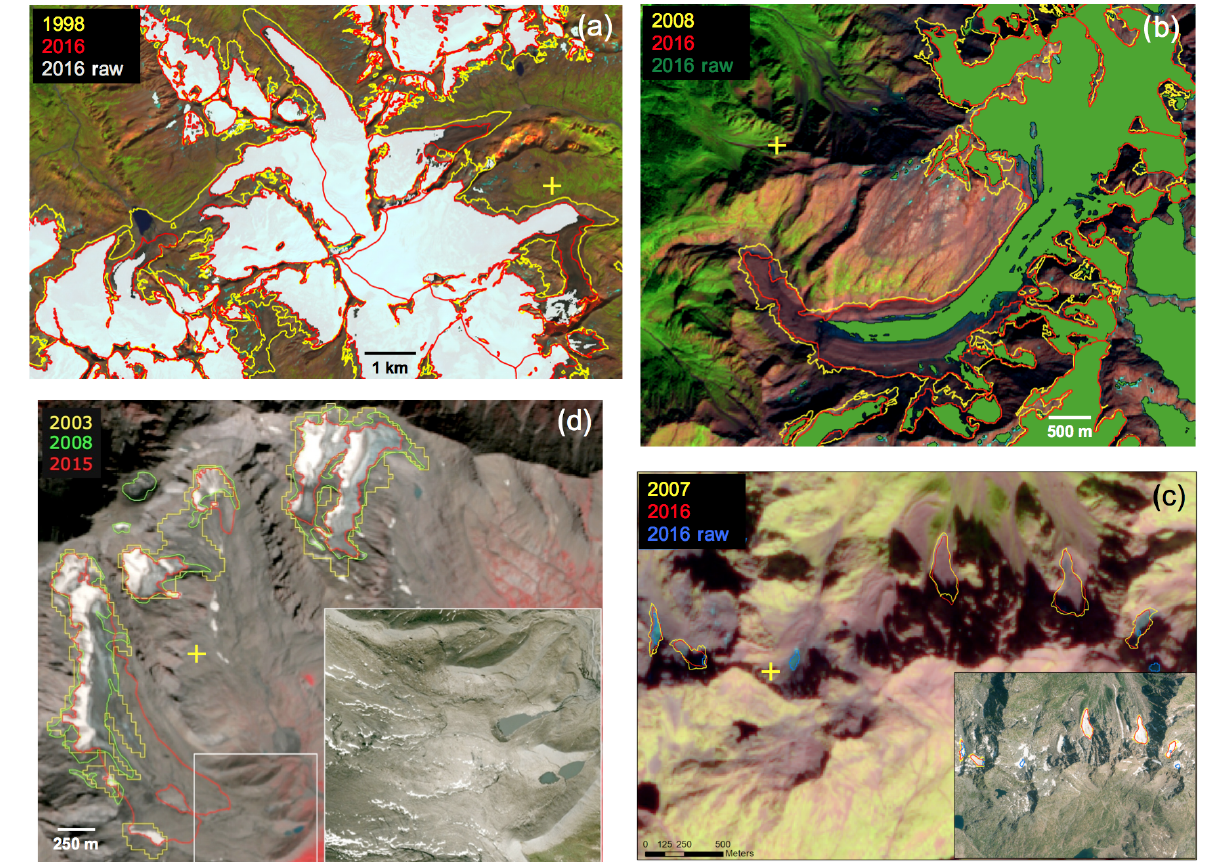
Figure 4. Examples of challenging classifications in different countries. (a) Debris cover delineation (red) around Grossvenediger (Hohe Tauern) in Austria with raw extents (light grey) and outlines from the previous national inventory (yellow). (b) Tré-La-Tête Glacier (Mont- Blanc), with automatically derived glacier extents (green), manually corrected outlines from 2015 (red), and outlines derived from aerial photographs taken in 2008 (yellow). The S2 image from August 2015 is in the background. (c) A subset of the Orobie Alps in Italy (S2 image from September 2016), with evidence of topographic shadow and debris-covered glaciers. The inset shows an aerial photograph with better glacier visibility but seasonal snow. (d) S2 image from 2015 showing differences in interpretation of debris cover for Gavirolas Glacier in Switzerland for the inventories from 2003 (yellow), 2008 (green), and 2015 (red). The inset shows a close-up of its lowest debris-covered part obtained from aerial photography for comparison (this image is a screenshot from Google Earth). The yellow crosses in each panel mark the following geographic coordinates: (a) 47.12 ◦ N, 12.4 ◦ E; (b) 45.8 ◦ N, 6.75 ◦ E; (c) 46.09 ◦ N, 10.07 ◦ E; and (d) 46.86 ◦ N, 9.06 ◦ E (image source: Copernicus Sentinel data 2015 and